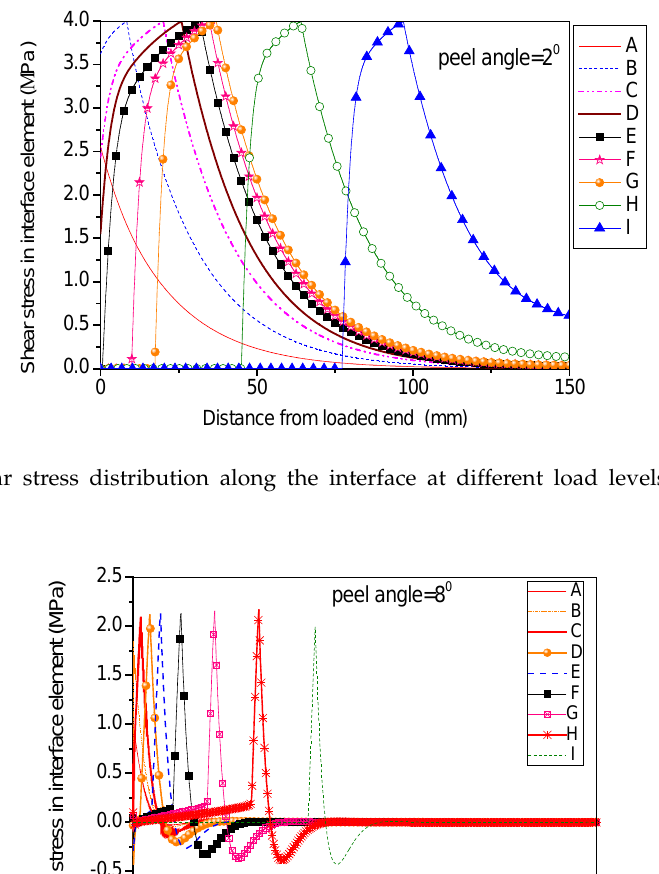
Figure 21. Normal stress distribution along the interface at different load levels when the peel angle = 8 degree.